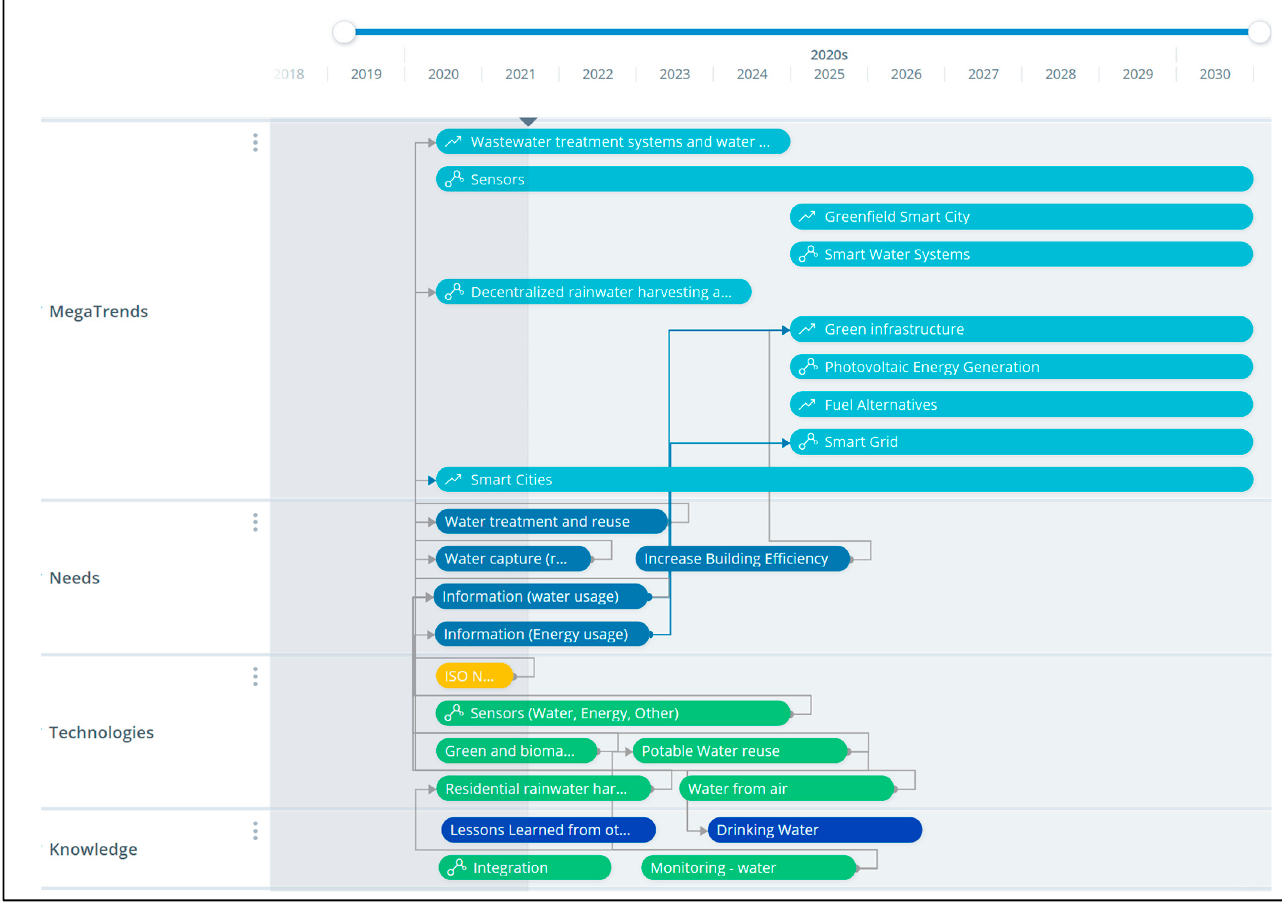
Figure 1. Megatrends, needs, and technologies identified and